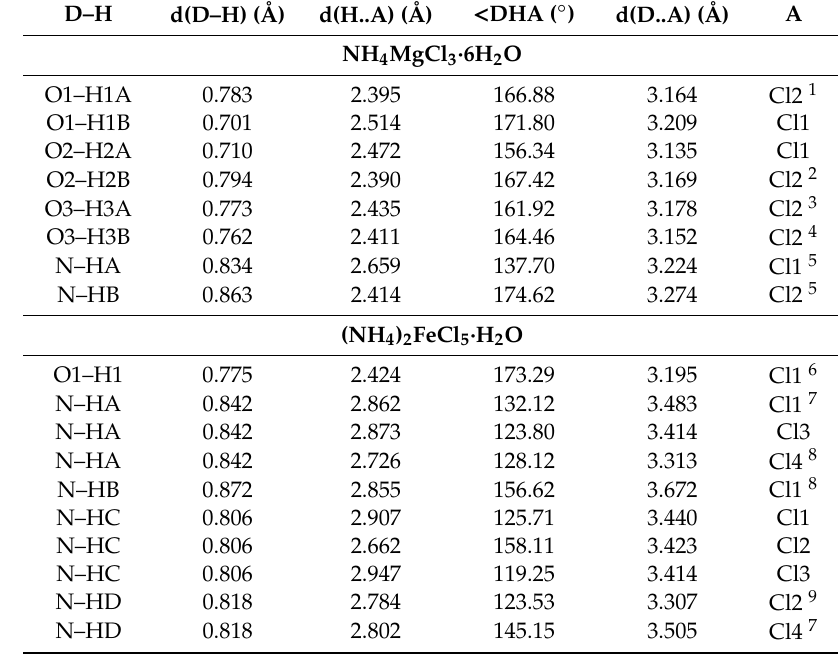
Table 9. Hydrogen bonds of NH 4 MgCl 3 · 6H 2 O and (NH 4 ) 2 FeCl 5 · H 2 O.